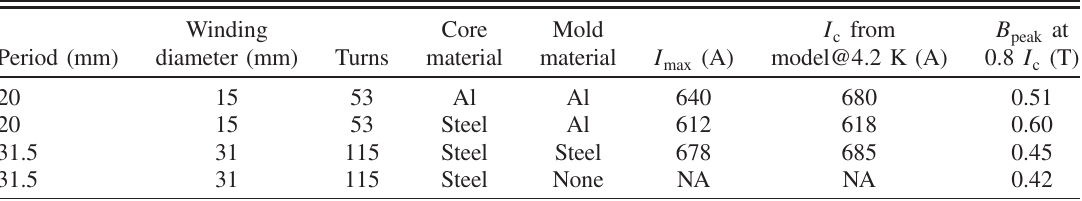
TABLE V. Summary table of the prototype